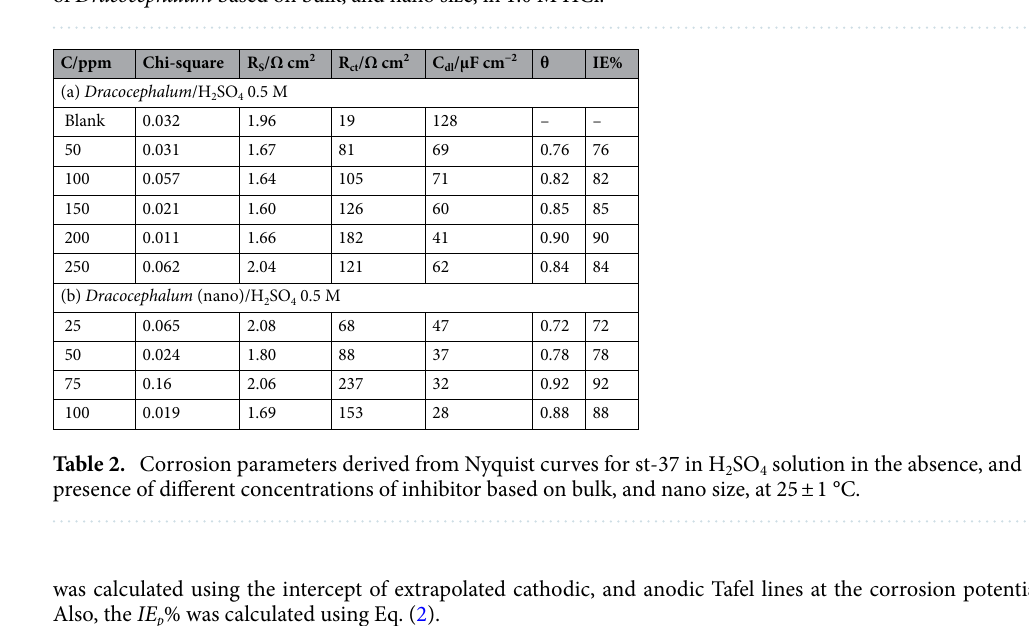
Figure 4. The ( a , b ) Nyquist plots, ( c , d ) bode plots, and phase angle plots for st-37 with different concentrations of Dracocephalum based on bulk, and nano size, in 1.0 M HCl.